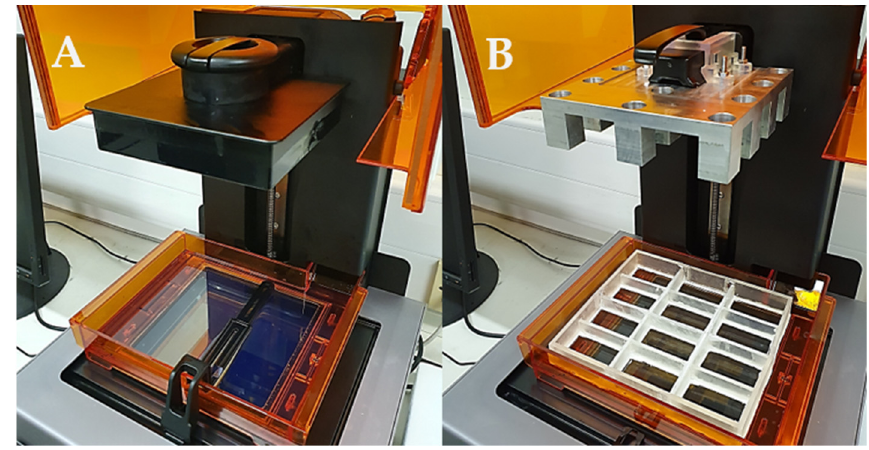
Figure 7. Comparison of ( A ) the original Form 2 SLA apparatus and ( B ) the novel SLA apparatus developed. The modified SLA apparatus allows operation with up to twelve different photopolymer formulations simultaneously. Each vat has been designed to contain 10 mL of resin formulation.